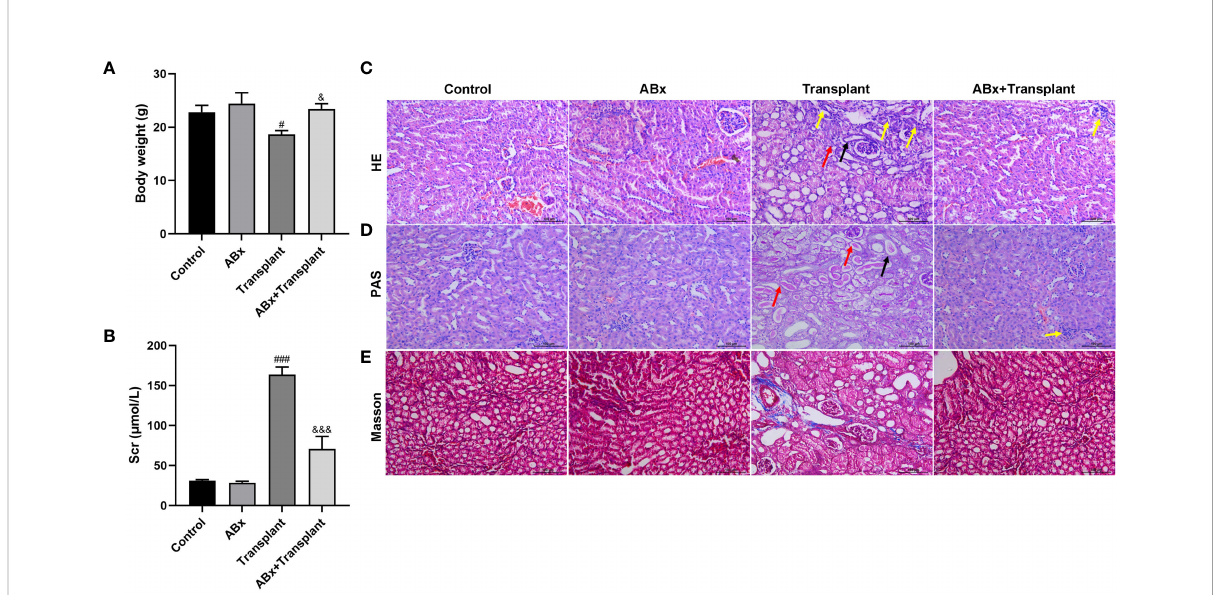
FIGURE 1 Effect of intestinal fl ora imbalance on renal transplantation in mice. Male BALB/c mice were purchased and randomly divided into 4 groups: Control group, intestinal fl ora imbalance group (antibiotics, ABx), renal transplantation group (Transplant), intestinal fl ora imbalance +renal transplantation group (Abx+Transplant). (A) The body weights. (B) The serum creatinine level. (C-E) HE, PAS and Masson staining for pathological examination. The yellow arrow indicates diffuse in fl ammatory cell in fi ltration, the black arrow indicates tubular necrosis, and the red arrow indicates tubulitis. # p < 0.05, ### p < 0.001 vs Control group; & p < 0.05, &&& p < 0.001 vs transplant